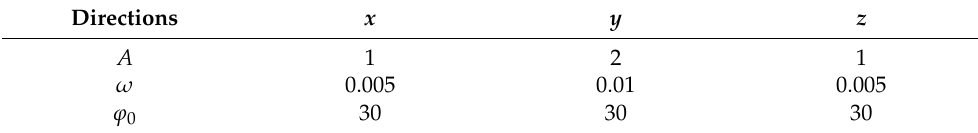
Table 3. Sinusoidal